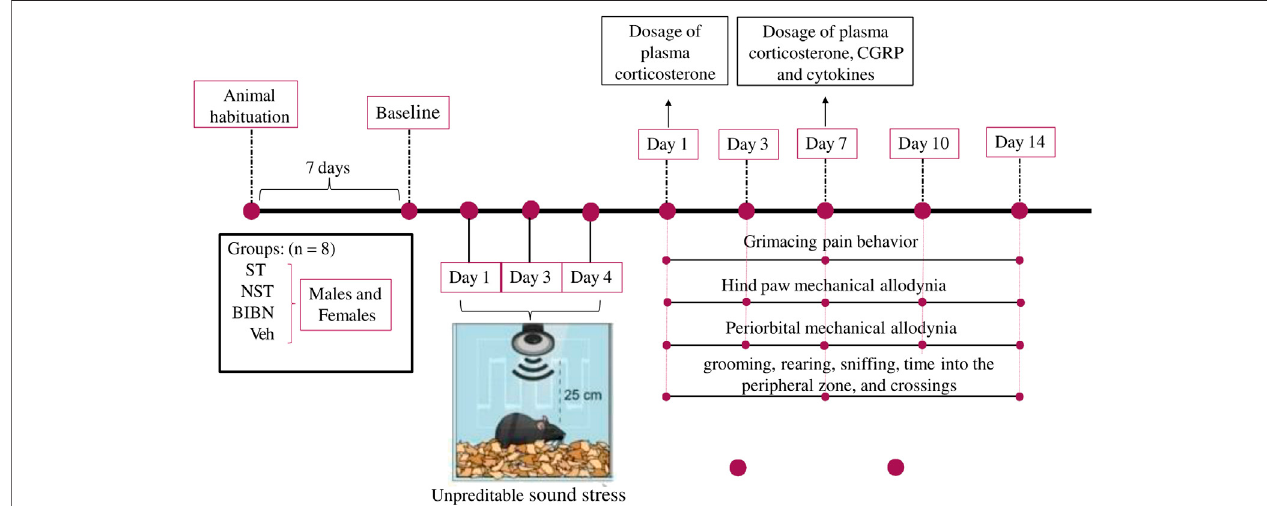
FIGURE 1 | Schematic representation of experimental design. Exposure to unpredictable sound stress occurred over 3 days lasting for fi ve or 10 s. Animals were exposed to the stressor for 3 nonconsecutive days (1, 3, and 4 days), for 30 min in each day. Day 1 post-stress induction described in our study, corresponds to day 5 (considering the beginning of the test). Animals were placed 4 – 5 per cage and the cage was placed 25 cm from a speaker that emitted four pure tones (5, 11, 15, and 19 kHz), whose amplitudes varied through time independently from 20 – 110 dB sound pressure level at random times each minute, lasting 5 or 10 s, and this unpredictable sound stress induction occurs for 30 min. Non-stressed (NST) animals were placed in the sound chamber for 30 min but without exposure to the sound stimulus. Following sound or non-stress, mice were returned to their home cages in the animal care facility. First, baseline grimace scale, periorbital and hind paw thresholds to von Frey fi laments were recorded for each animal (7 days after animal habituation). After the last stress section induction (on day 4), the behavioral experiments were evaluated on days 1, 3, 7, 10, and 14 days. Subsequently, on the nociceptive peak after stress induction (7 days), the treatment protocol with CGRP antagonist and the different plasma analyses were performed (in a different group of